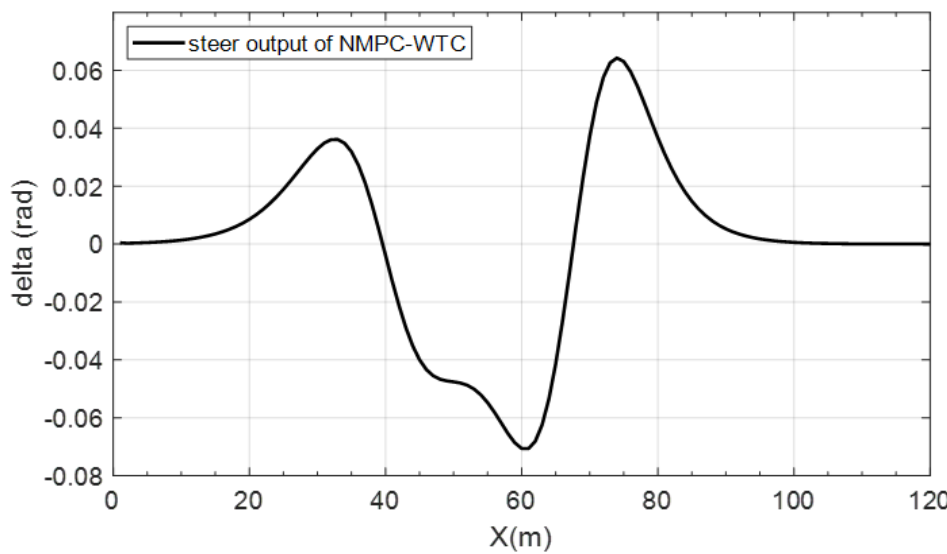
Figure 7. Steer output of proposed NMPC – WTC path tracking method.